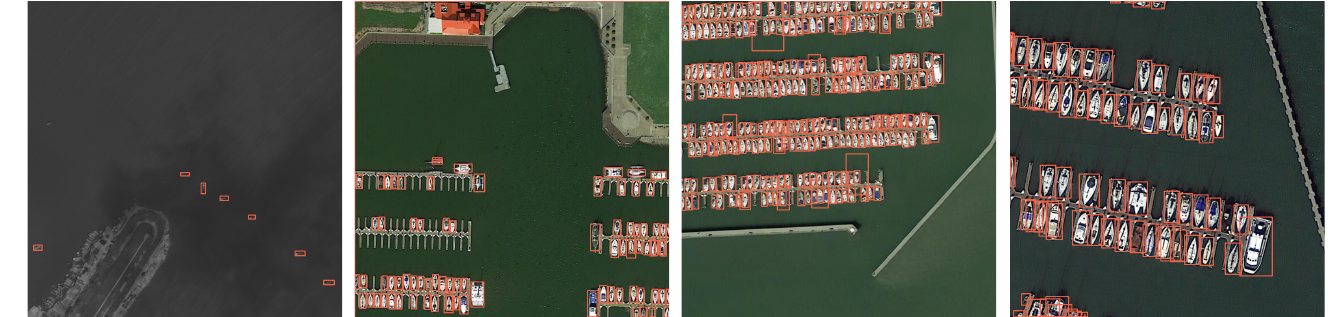
Figure 11. Detection results of LR-TSDet on the DOTA-Ship